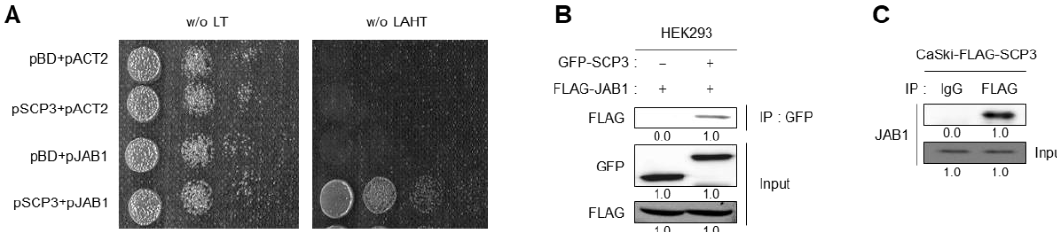
Figure 4. SCP3 interacts with JAB1. ( A ) Positive protein-protein interactions were determined by monitoring cell growth over 3 days on a medium lacking Leu and Trp (w/o LT), or a medium lacking Leu, Trp, His and Ade (w/o LAHT). ( B ) Co-immunoprecipitation of SCP3 and JAB1. HEK293 cells were co-transfected with the indicated constructs. Lysates of the transfected cells immunoprecipitated with the GFP antibody, followed by Western blotting using GFP and FLAG antibodies. ( C ) SCP3 bound to endogenous JAB1 in CaSki-SCP3 cells. Immunoprecipitation was performed using rabbit IgG or FLAG antibody, followed by Western blotting using the indicated antibodies. All experiments were performed in triplicate.